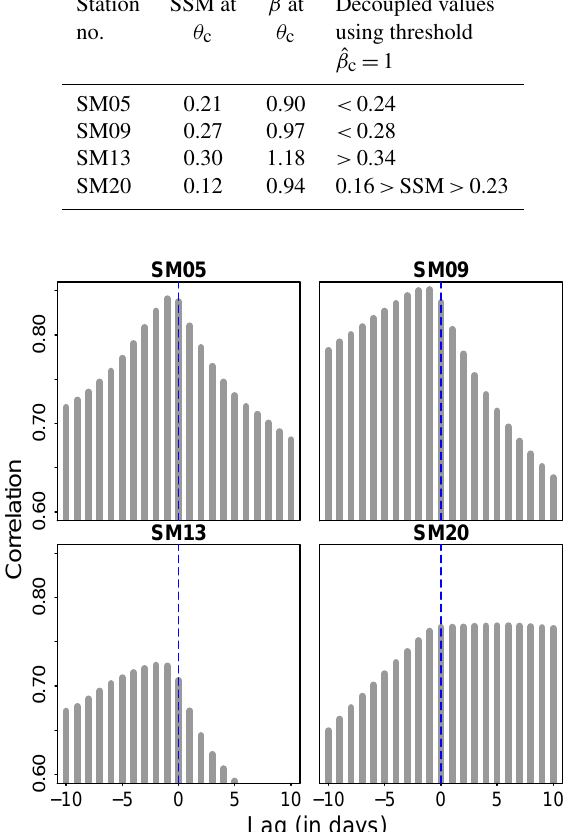
Figure 7. Cross-correlation plots of soil moisture values. The lagged surface soil moisture values at 5cm are correlated with sub- surface values at 40cm. A 1–2 day lead of surface soil moisture is observed, except for SM20. This is indicated by maximum cor- relation values at lags of − 1 to − 2 days. At SM20, the maximum correlation occurs at positive